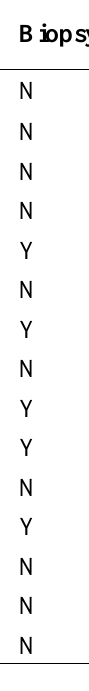
Table 1. Clinical parameters of 15 inpatients with NSAID induced AKI